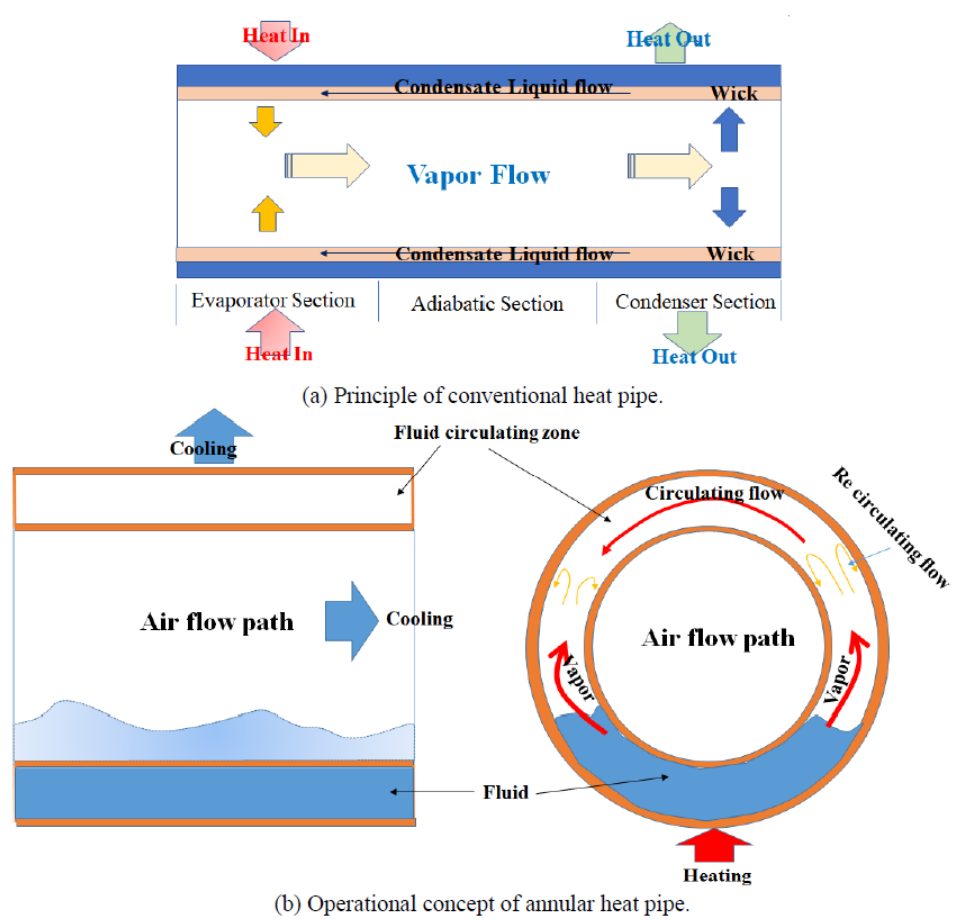
Figure 1. Conventional heat pipe principle and annular heat pipe concept design.